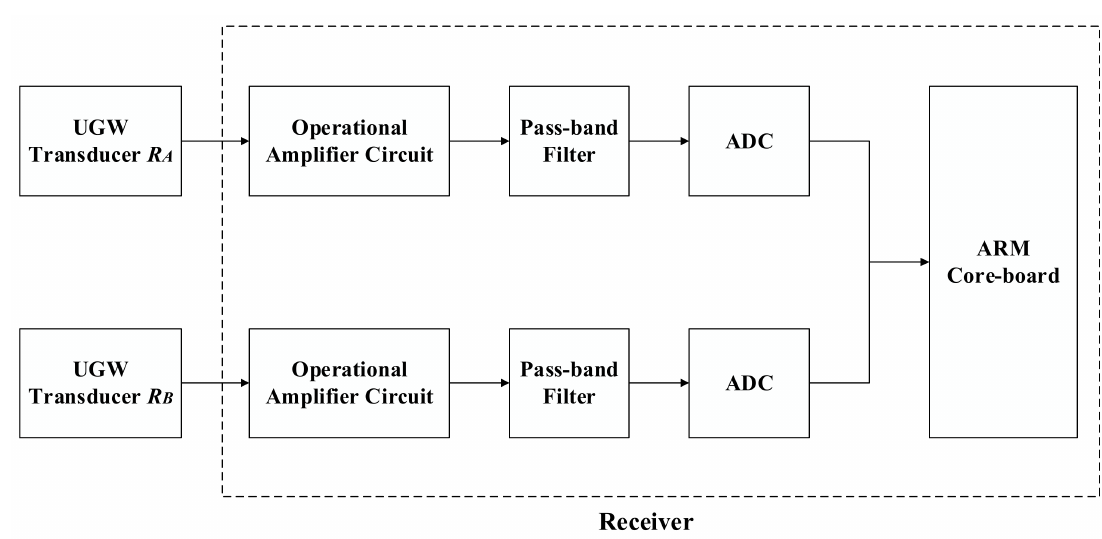
Figure 3. Block diagram for the UGW